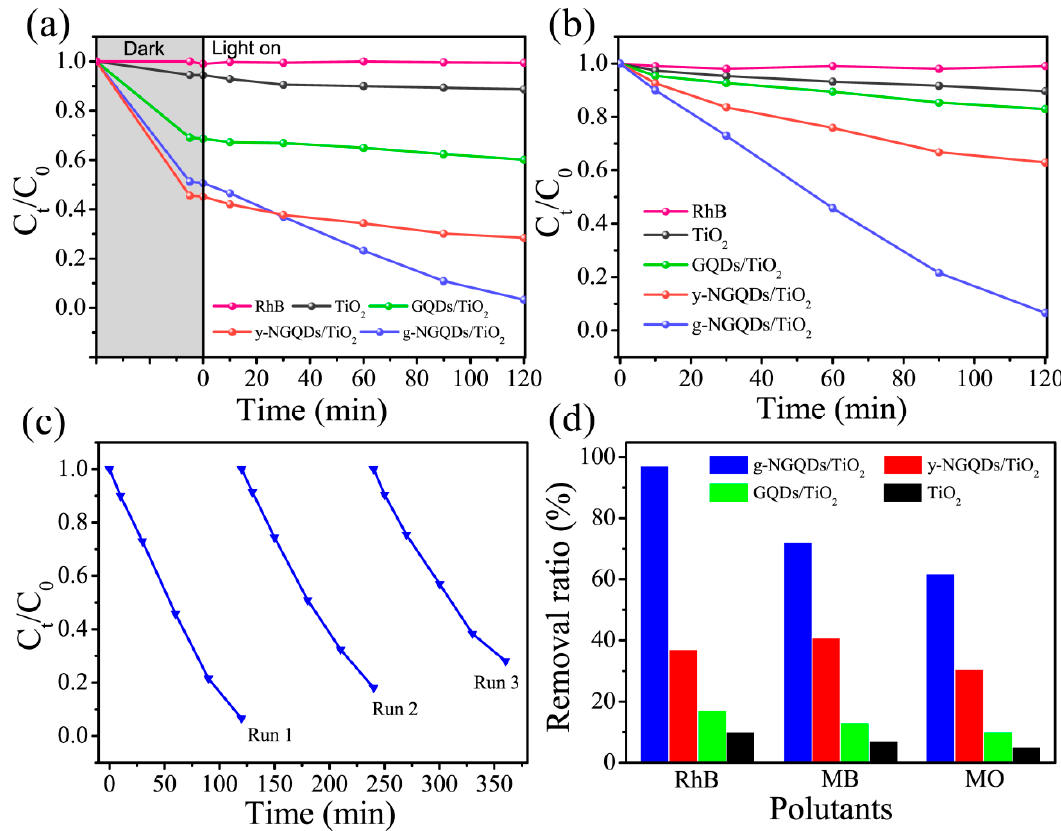
Figure 4. ( a ) RhB (Rhodamine B-Hyaluronate) absorption property and photodegradation activities under visible light irradiation ( λ > 420 nm) of TiO 2 , GQDs/TiO 2 , g-NGQD/TiO 2 and y-NGQD/TiO 2 composites; ( b ) Visible-light driven photocatalytic degradation rates of RhB by TiO 2 , GQDs/TiO 2 , g-NGQD/TiO 2 and y-NGQD/TiO 2 composites; ( c ) Recycling test of the g-NGQDs/TiO 2 for photocatalytic degradation of RhB aqueous solution under visible light irradiation ( λ > 420 nm); ( d ) The removal ratios of RhB, MB and MO under visible light irradiation ( λ > 420 nm) using TiO 2 , GQDs/TiO 2 , g-NGQD/TiO 2 and y-NGQD/TiO 2 composites.